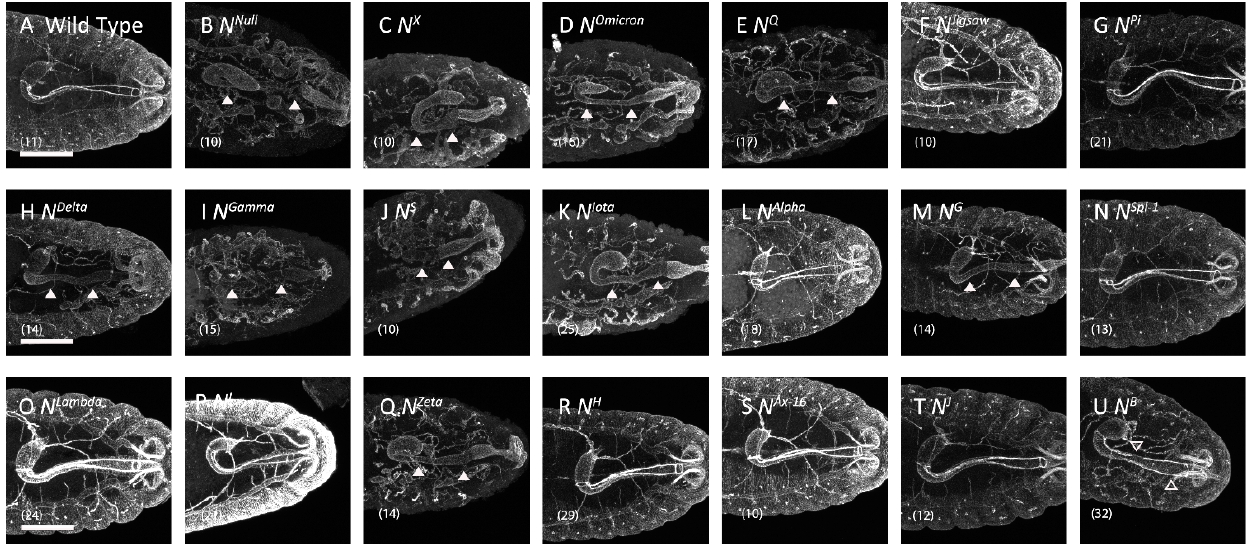
Figure 3. Notch alleles that induced defects in boundary cell formation. Dorsal views of the embryonic hindgut epithelium, stained with an anti-Crumbs antibody to detect boundary cells (white), in ( A ) wild-type embryos and the following hemizygotes: ( B ) N 55 e 11 , an amorphic allele of Notch ; ( C ) N X , ( D ) N Omicron , ( E ) N Q , ( F ) N Jigsaw , ( G ) N pi , ( H ) N Delta , ( I ) N Gamma , ( J ) N S , ( K ) N Iota , ( L ) N Alpha , ( M ) N G , ( N ) N Spl − 1 , ( O ) N Lambda , ( P ) N I , ( Q ) N Zeta , ( R ) N H , ( S ) N Ax − 16 , ( T ) N J , and ( U ) N B . Filled white arrows indicate regions where anti-Crumbs antibody staining is depleted. Arrows outlined in white indicate regions where anti-Crumbs antibody staining showed abnormal gaps. The number of embryos analyzed is shown in parentheses. Scale bars: 50 μ m.